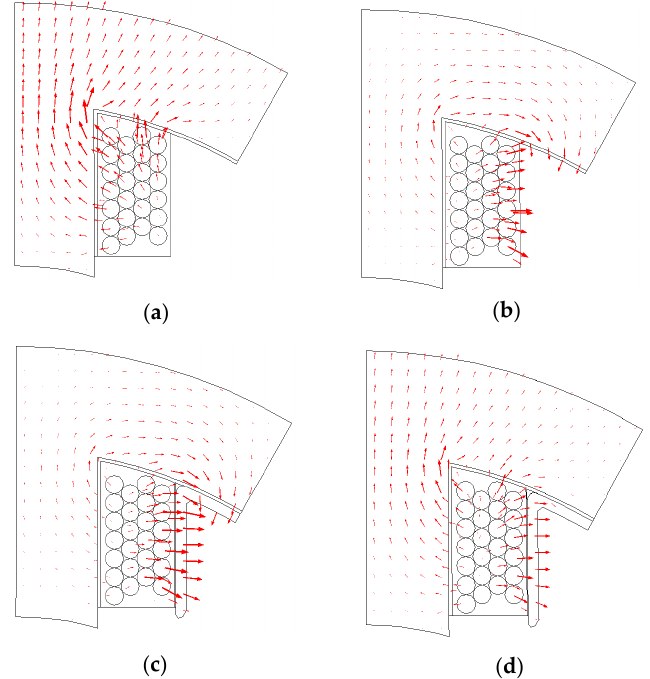
Figure 5. Heat flow path for different cooling cases: ( a ) water jacket cooling WJ1 and WJ2; ( b ) Direct coil cooling DCC1; ( c ) Direct coil cooling DCC2 and; ( d ) combined cooling WJ(x) + DCC2.